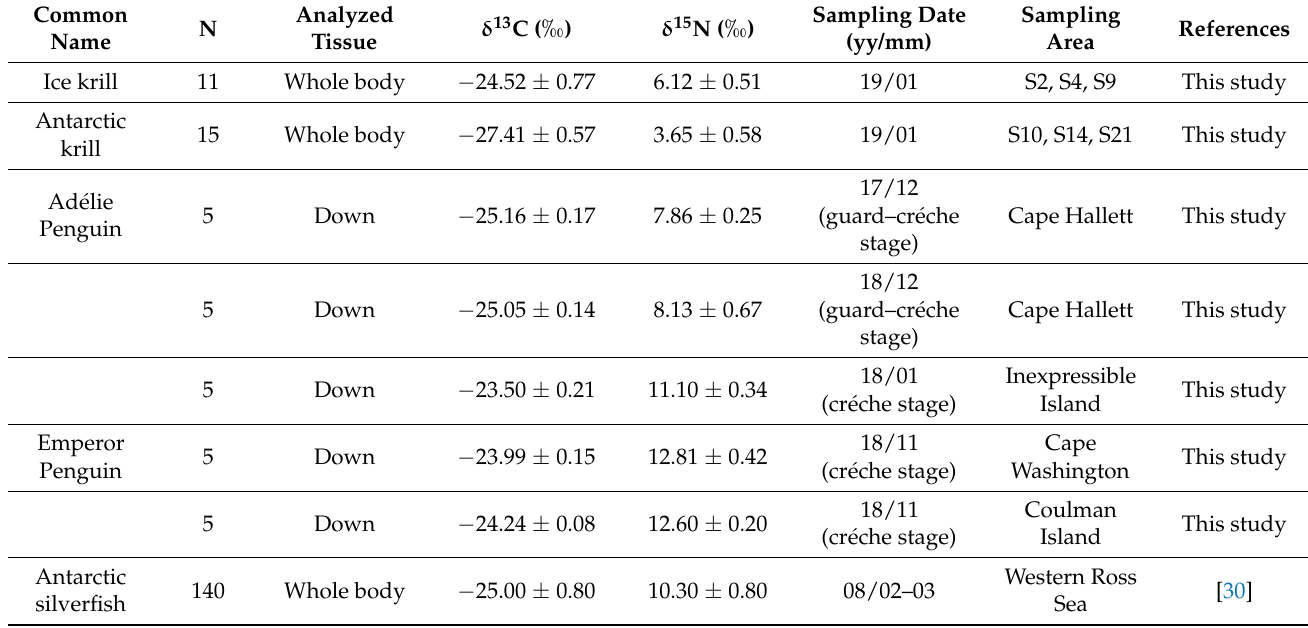
Table 1. Sampling details and stable isotope signatures of prey items and penguin